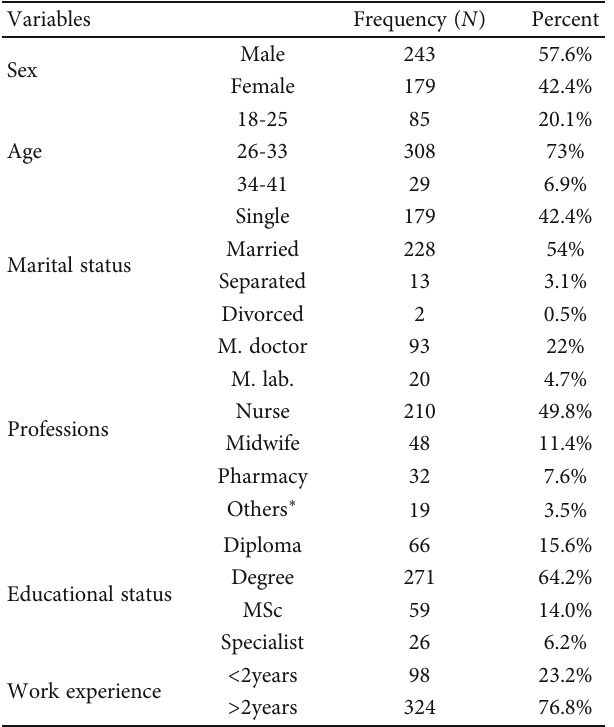
Table 1: Sociodemographic characteristics of the respondent at Tibebe Ghion Specialized Hospital from January 1 to February 30,